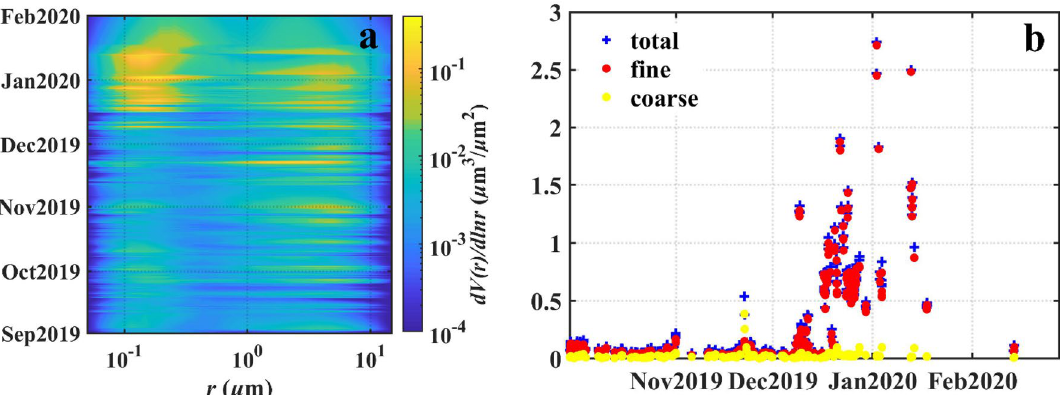
Figure 3. ( a ) Aerosol particle size distribution from September 2019 to February 2020 at the Tumbarumba site. ( b ) Daily SDA retrievals of the total, fine, and coarse mode AOD 440 values from October 2019 to February 2020 at the Tumbarumba